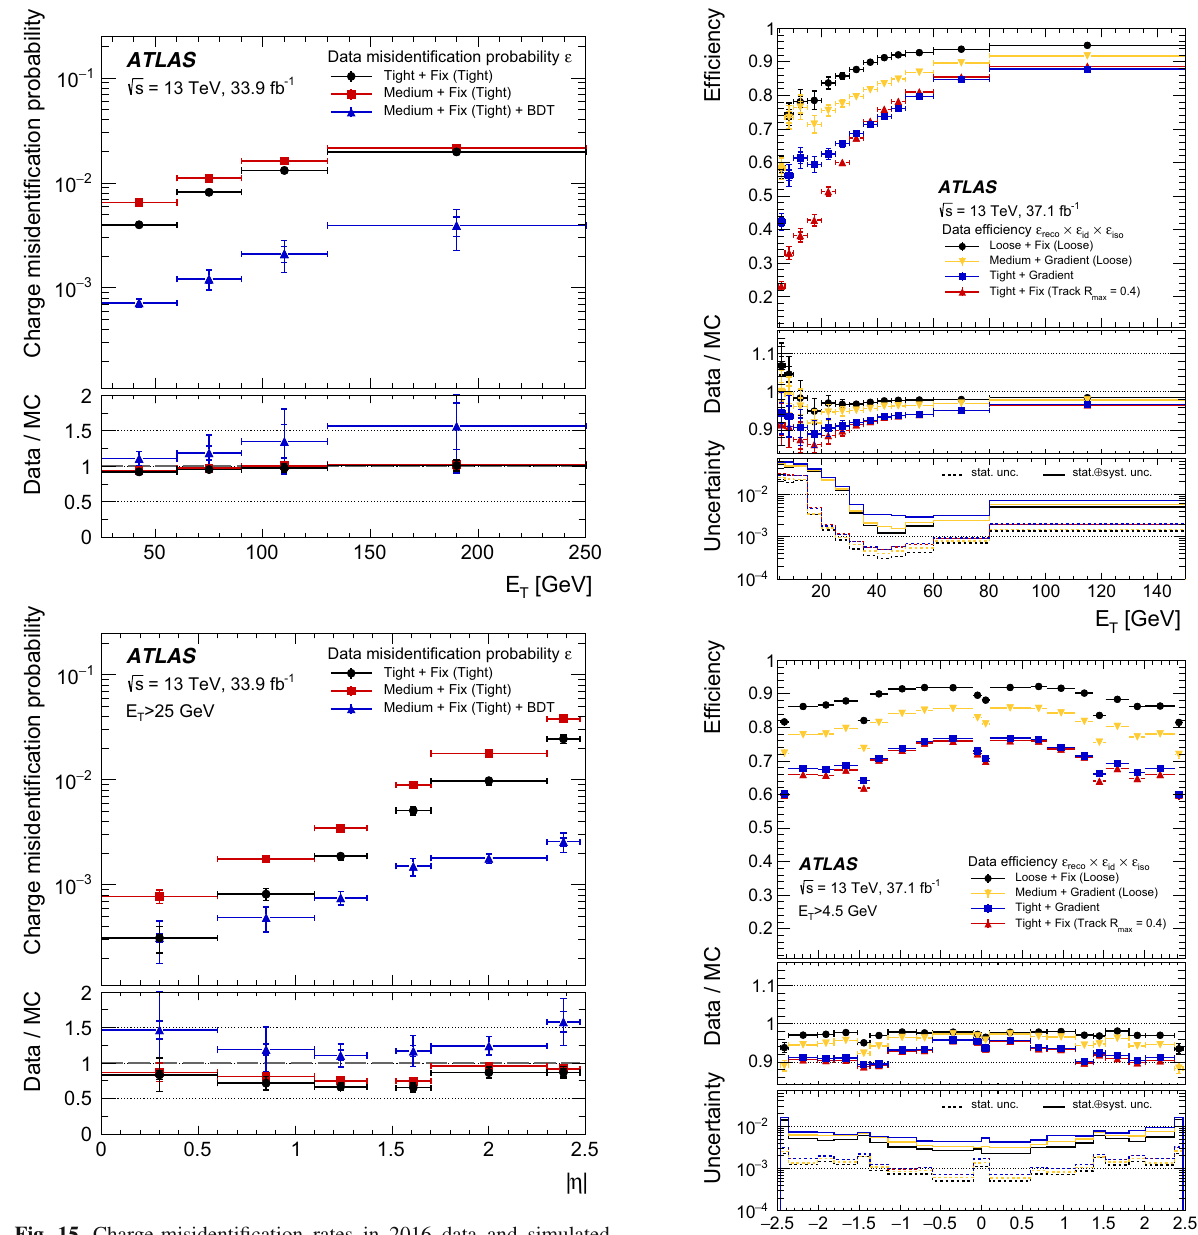
Fig. 15 Charge-misidentification rates in 2016 data and simulated Z → ee events as a function of E T (top) and | η | (bottom) showing the impactofapplyingtheBDTrequirementtosuppresschargemisidentifi- cation (red squares vs. blue triangles). Medium identification with BDT vs. Tight identification without BDT is also explored (black circles vs. blue triangles). The Fix (Tight) isolation requirement is applied in all cases (see Table 4). The inner uncertainties are statistical while the total uncertainties include both the statistical and systematic components